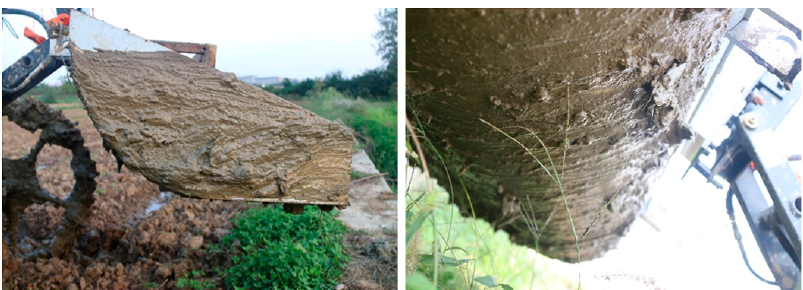
Figure 1. Soil–tool adhesion phenomena during the flattening operations in paddy fields.